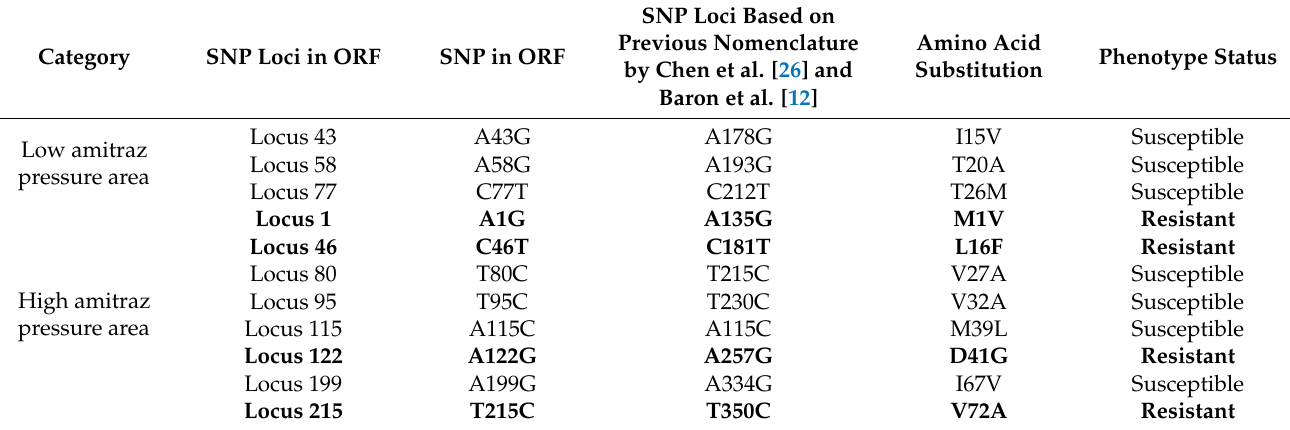
Table 2. Non-synonymous mutations in the partial coding region of Rhipicephalus ( B .) decoloratus OCT/Tyr gene and corresponding substitution in amino acid